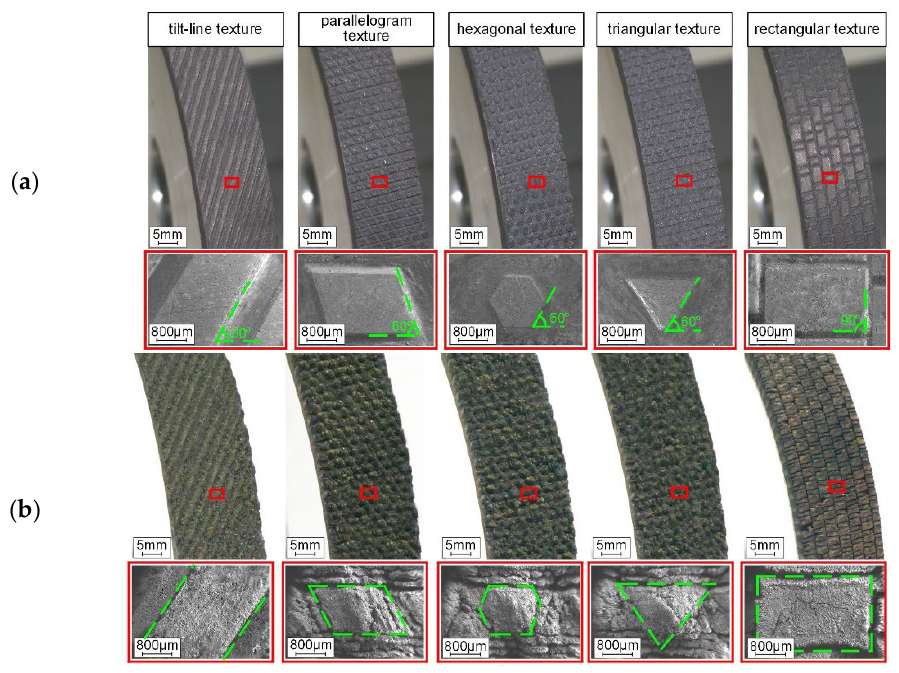
Figure 13. Texture appearance obtained using ( a ) appropriate and ( b ) inappropriate parameters [92].